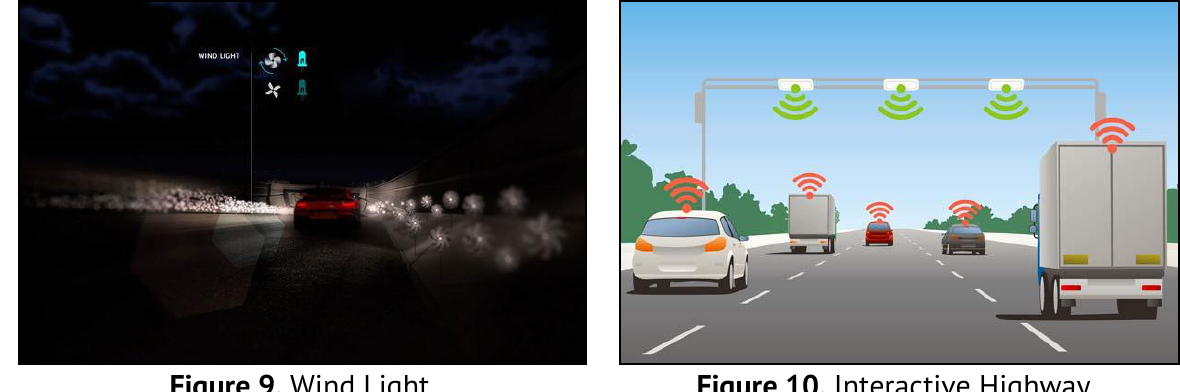
Figure 9. Wind Light. Figure 10. Interactive Highway.